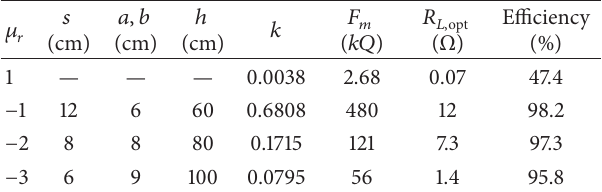
Table 1: Comparison of WPT efficiencies when using lossless